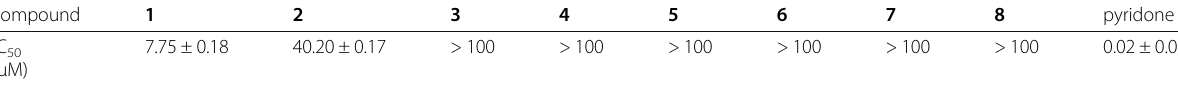
Table 2 Effects of compounds 1 – 8 on IL-6/STAT3 activity in HepG2/STAT3 cells